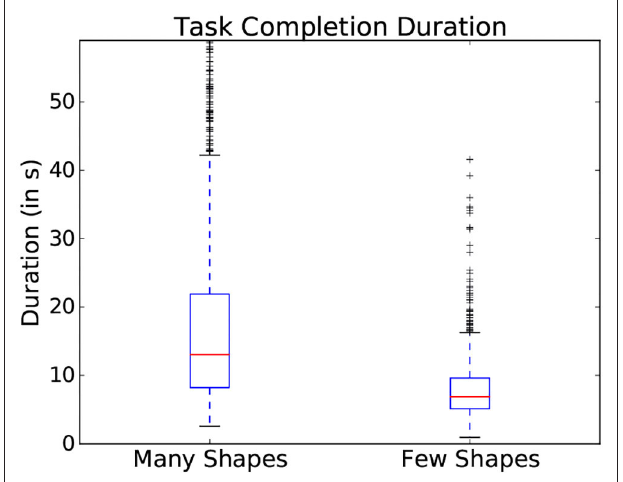
FIGURE 5 | Variation of number of revisits of target scene depending on the color similarity present in a scene. Data from all participants is used in this